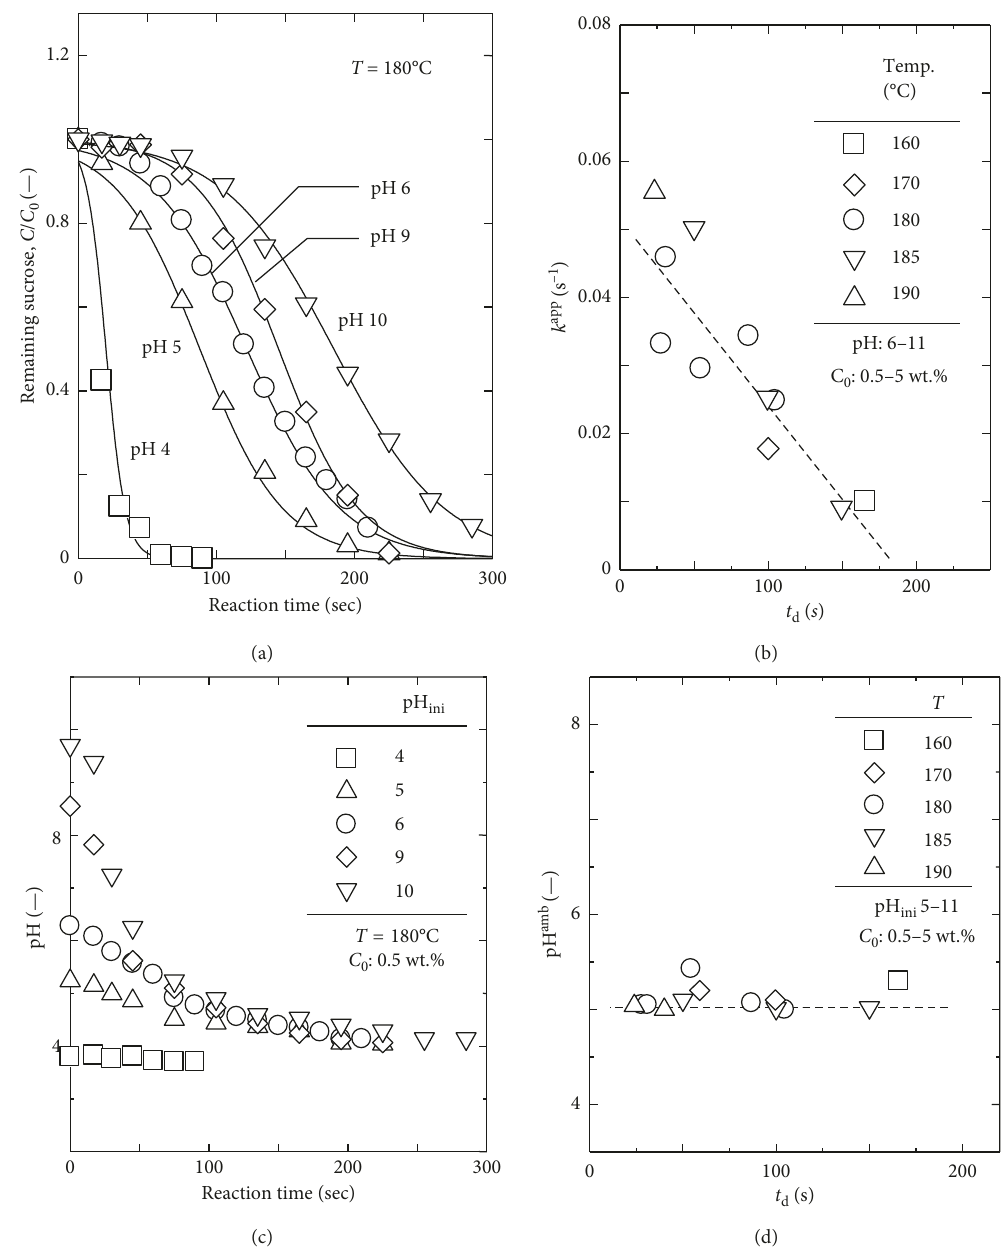
Figure 3: Kinetic pH titration. (a) Time course of remaining sucrose concentration under various pH conditions at 180 ° C. The experiment was performed at 180 ° C, 10 MPa, C 0 � 0.5wt%, and initial pH 4–10. (b) Relationship between the induced time ( t d ) and apparent rate constant ( k app ). (c) Time course of the pH at the outlet of reaction system. (d) Relationship between t d and the corresponding pH (pH amb